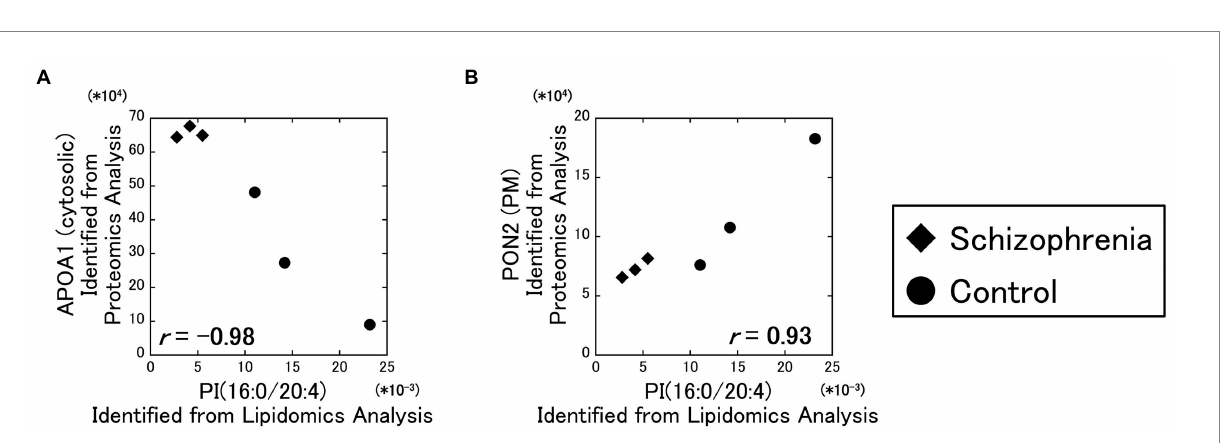
FIGURE 3 Relationships between the lipidomics and the proteomics factors. The signal intensity of the PI (16:0/20:4) were plotted against the amounts of the identified proteins. All data including other lipids and proteins are available on Supplementary Figure 3. Diamonds: samples from schizophrenia patients. Circles: samples from control